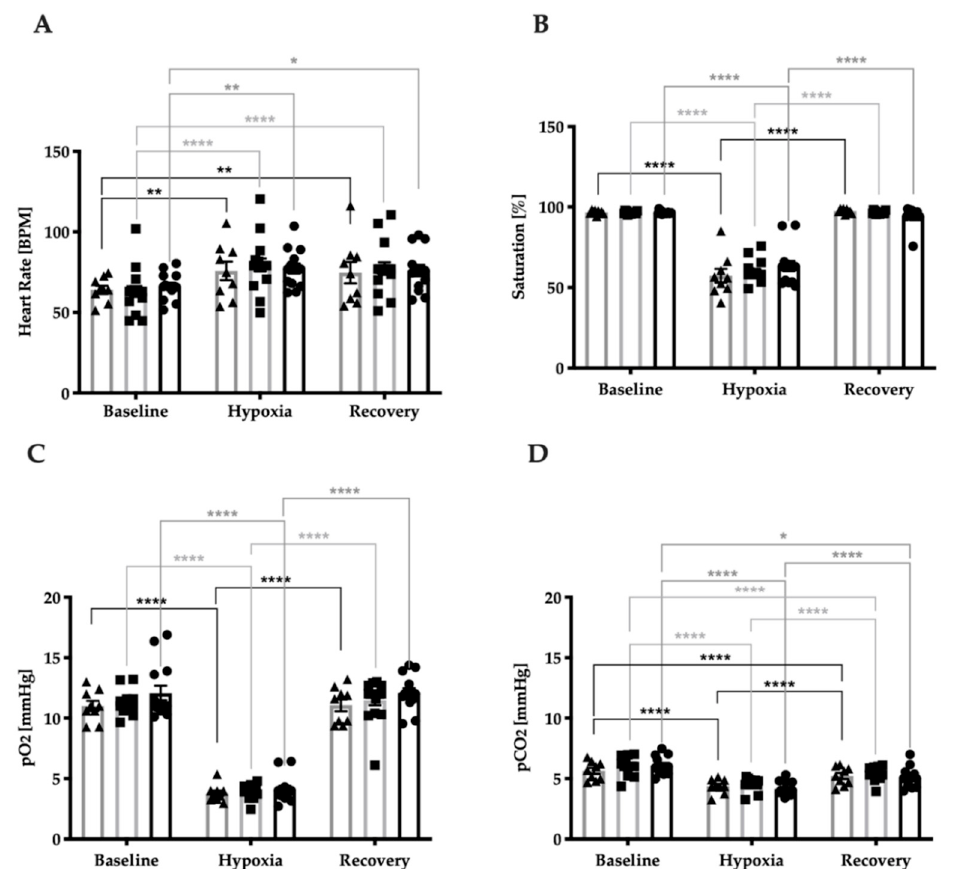
Figure 2. Stress responses of systemic vital parameters in patients with OHT ( ▲ ), patients with normal-tension glaucoma (NTG) ( ∎ ), and controls ( ● ). Heart rate (HR) ( A ) was measured by a Nexfin monitor. Saturation (SAT) ( B ), partial pressure of oxygen (pO 2 ) ( C ), and partial pressure of carbon dioxide (pCO 2 ) ( D ) were detected by the ABL8000Flex in arterial blood gas. Data are presented as mean ± SEM. Two-way ANOVA with Tukey’s multiple comparisons test. * p < 0.05; ** p < 0.01; **** p < 0.0001.